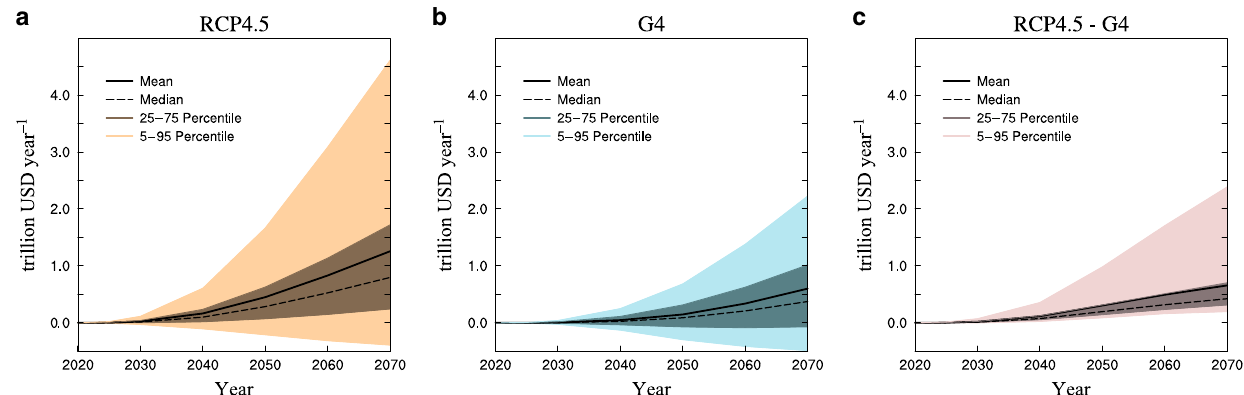
Fig. 5 Economic impacts of permafrost CO 2 and CH 4 emissions. Predicted annual economic losses due to PCF under ( a ) the geoengineering experiment G4 and ( b ) the emission scenario RCP4.5, as well as ( c ) the difference (RCP4.5 – G4), obtained from 100,000 Monte-Carlo runs of PAGE-ICE driven by projected permafrost CO 2 and CH 4 emissions. Solid black lines represent the mean values; dotted black lines show the median values; light and dark color intervals show 5 – 95% and 25 – 75% con fi dence intervals, respectively. Negative values under RCP4.5 and G4 indicate that the PCF may bring economic bene fi ts due to the net C gains simulated by GISS-E2-R